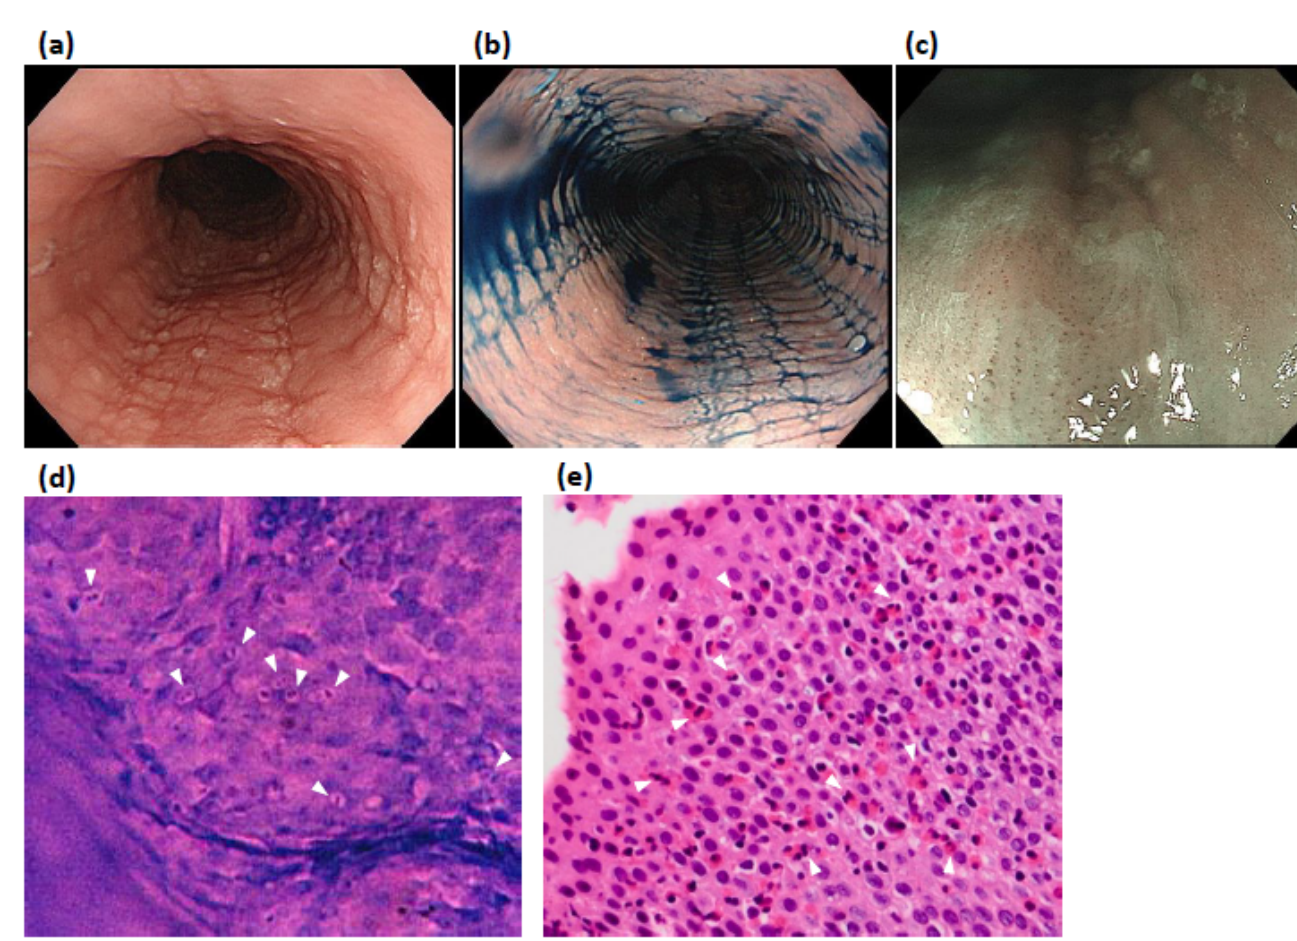
Figure 2. A 52-year-old male was referred to our university hospital because of heartburn and dysphagia that was refractory to proton pump inhibitors. WLE and imdigocarmine chromoendoscopy revealed linear furrows, exudates, and rings in the upper and middle esophagus ( a , b ). NBI-ME showed a beige-colored mucosa and dot-shaped IPCLs in the mucosal sites without visibility of cyan vessels ( c ). Endocytoscopy (magnification ×520) demonstrates multiple cells with purple bilobed nuclei with a nonstained periphery (( d ), white arrowheads). This finding was suggestive of eosinophilic infiltration. Biopsy samples were collected at the site of endocytoscopic observation. The histology showed >50 eosinophils, several showing bilobed nuclei per high-power field (( e ), white arrowheads showing representative bilobed nuclei of eosinophilic